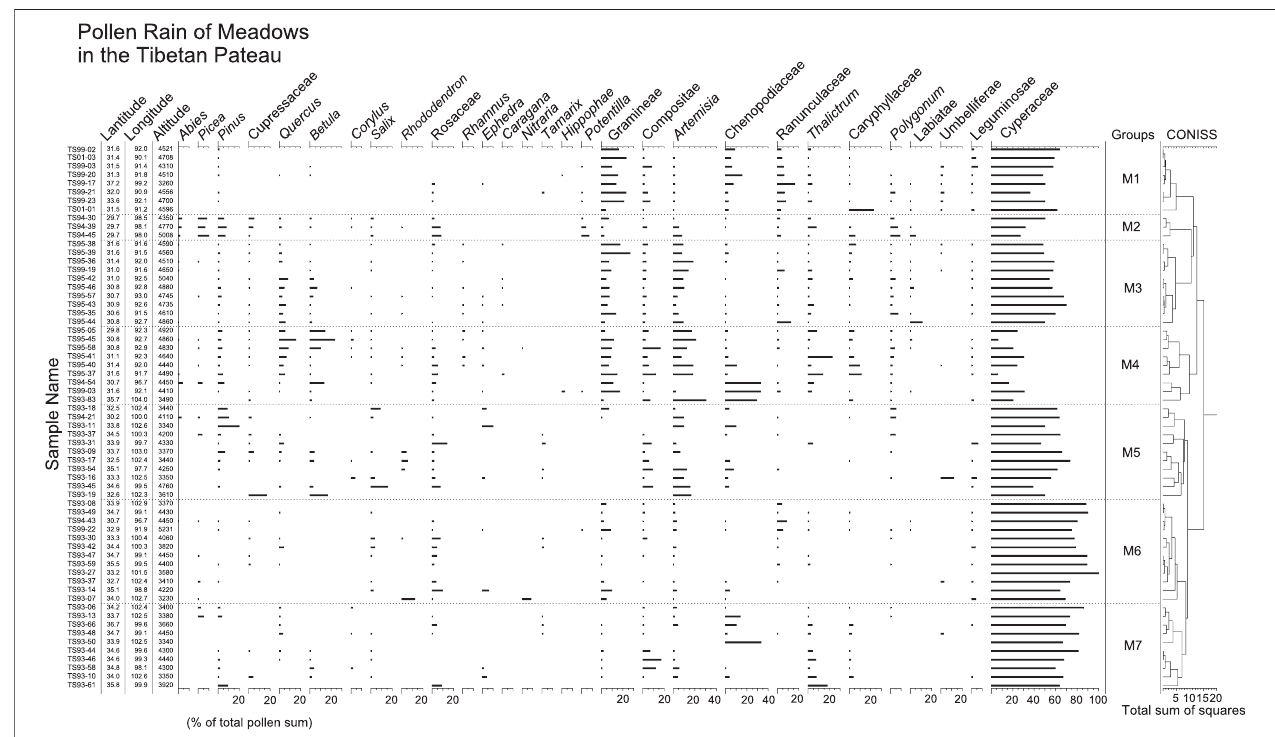
FIGURE 6 | Pollen percentage diagram for surface samples from meadows in the TP. Samples of groups M1-3, M4, M5-7 are mainly from alpine meadows, steppe-meadows, and alpine marshy meadows, respectively.